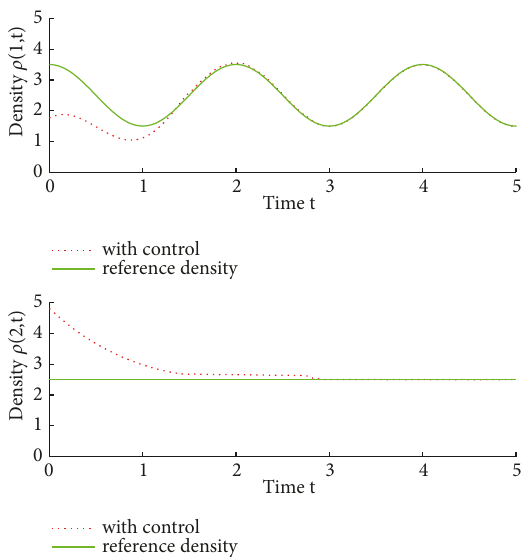
Figure 8: Density evolution at 𝑥 = 1 and 𝑥 = 2 with reference 𝑅 = 2.5 + sin (0.5𝜋𝑥) cos (𝜋𝑡)